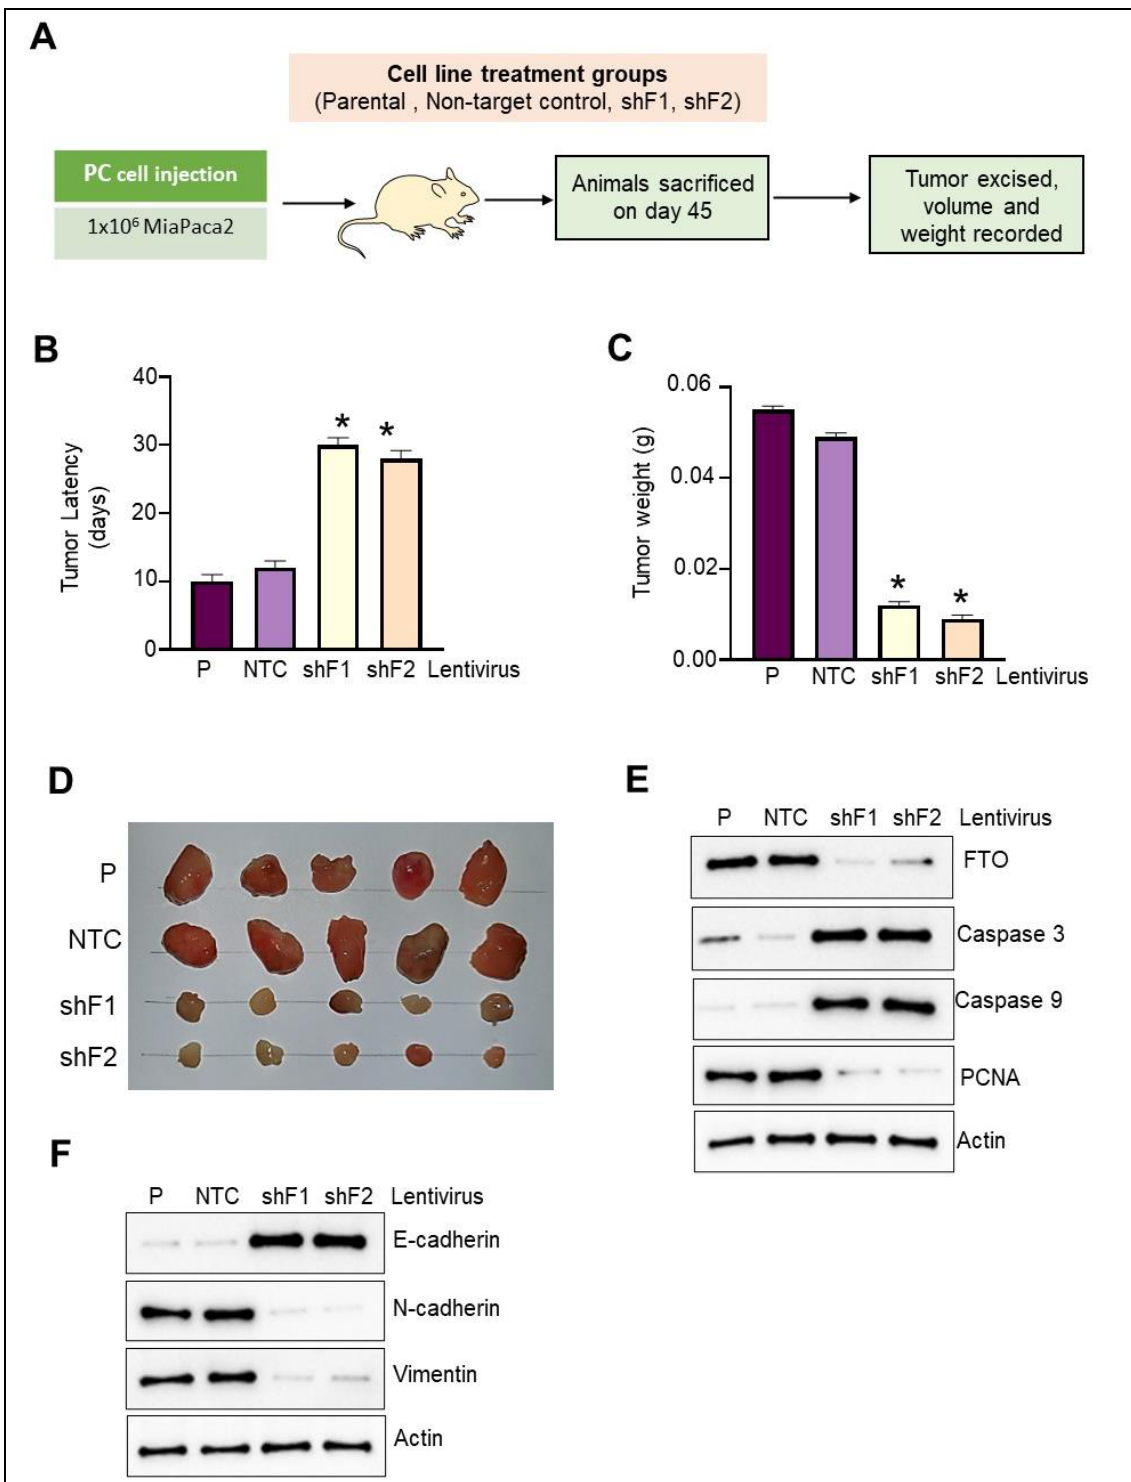
Figure 6. FTO is required for PC tumor growth in athymic nude mice. MiaPaca2 cells (parental, expressing shRNA control (NTC) or FTO (shF1 and shF2) at 80% confluency were resuspended in serum-free medium, and then 0.1 mL containing 1 × 10 6 cells were injected subcutaneously into the flank of 6-week old male athymic nude-Foxn1nu mice. ( A ) Experimental design. ( B ) FTO depletion caused the delay in the tumor onset, which is depicted as the tumor latency. Each group includes 10 mice. ( C ) Graph representing final tumor weight and ( D ) a representative image of the xenograft tumors. ( E ) protein expression of apoptosis and proliferation markers as analyzed by Western blot in the total cell extracts prepared from the xenograft tumors from different groups. Representative